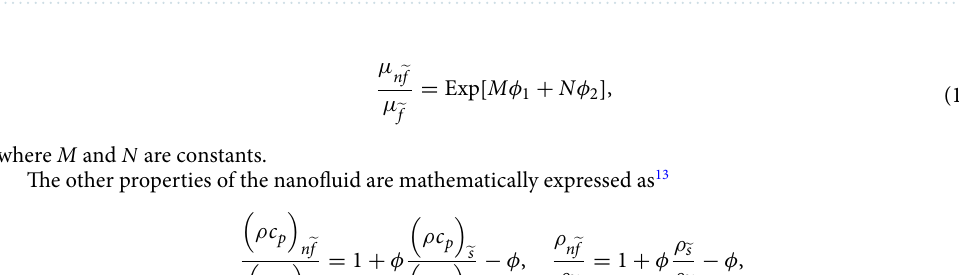
Table 1. Thermophysical properties of Aluminum Oxide and base fluid water 37